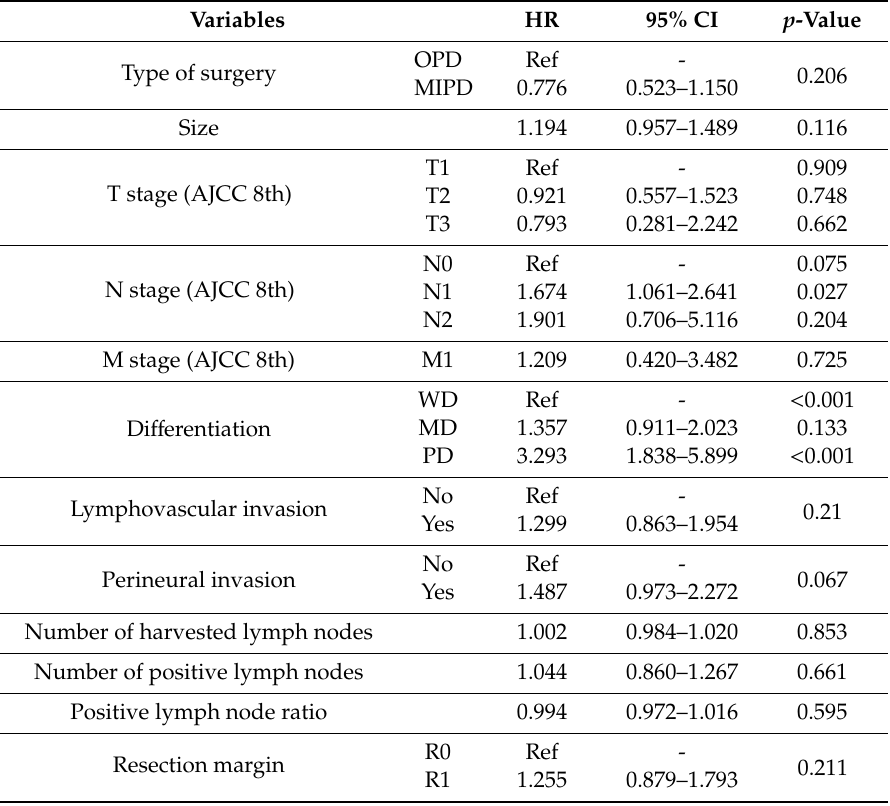
Table 8. Multivariable model of risk factors for disease-free survival after propensity score matching.